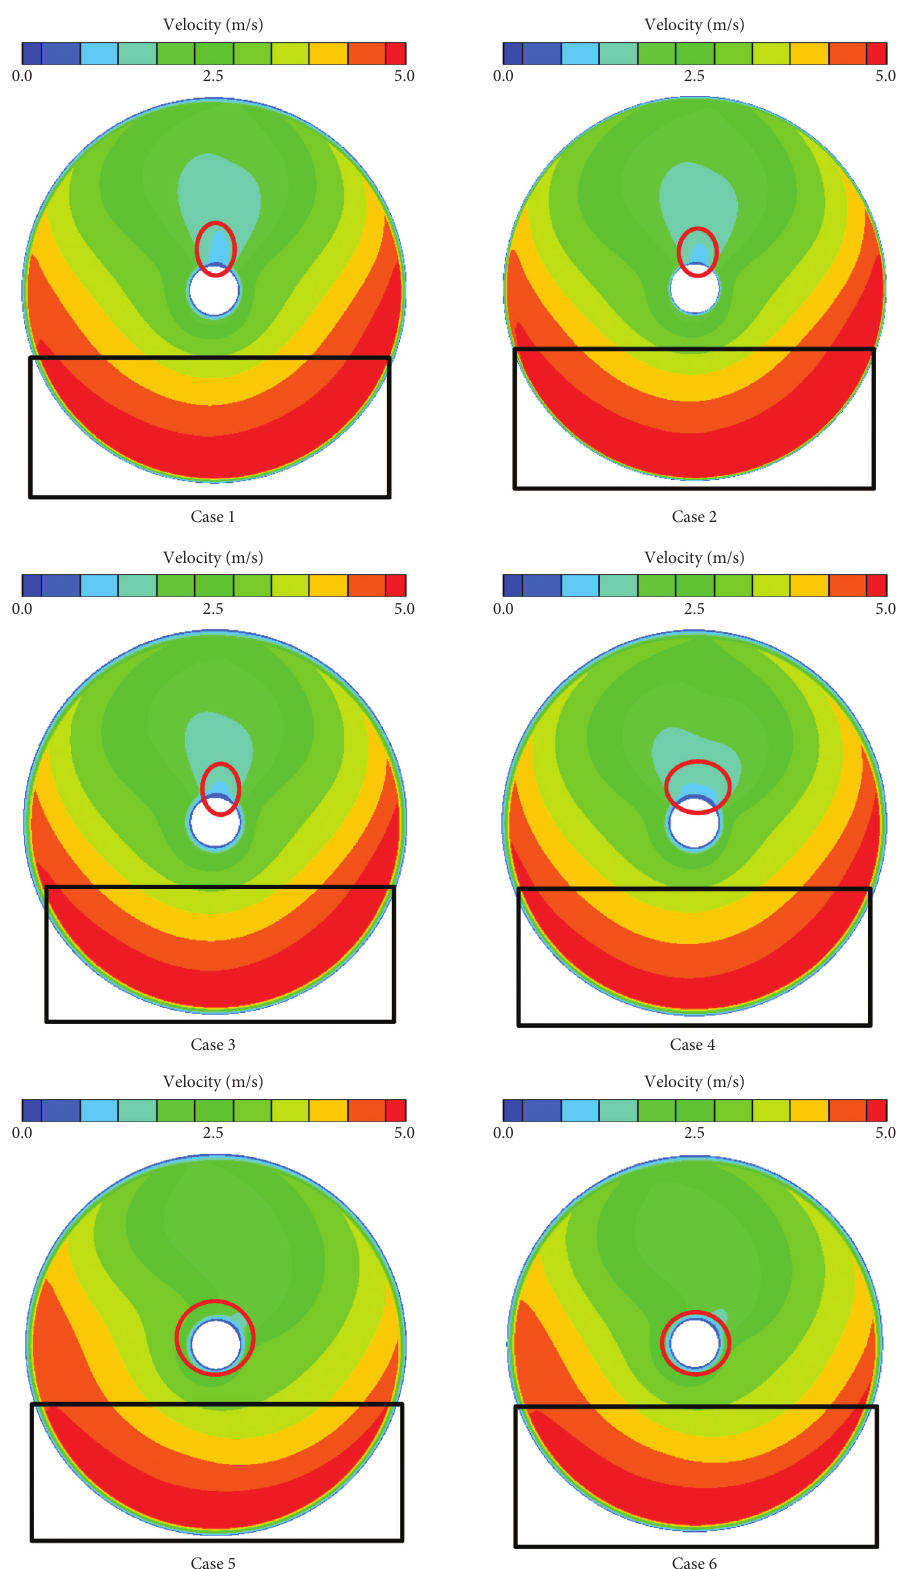
Figure 11: Cloud diagram of the velocity distribution at the exit of different inlet duct